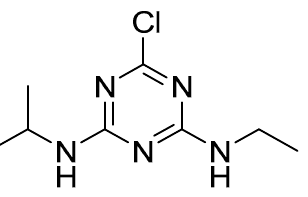
Figure 1. Atrazine (2-chloro-4-ethylamino-6-isopropylamino-1,3,5-triazine).